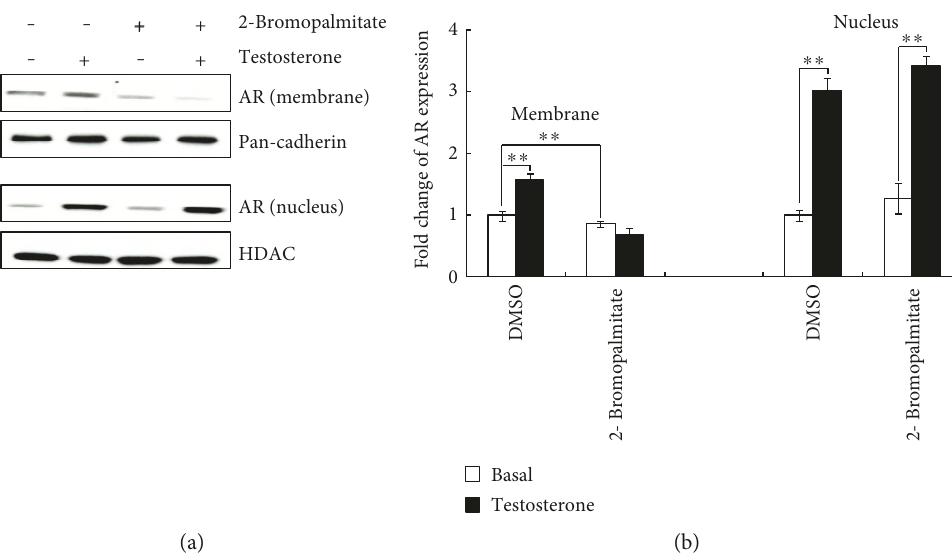
Figure 4: 2-Bromopalmitate prevented AR translocation to membrane. (a) Representative Western blot images showing AR transport in the membrane and nuclear fraction proteins from cells preincubated with vehicle (DMSO) or 2-bromopalmitate for 2 h before exposure to 10nM testosterone. (b) Pooled data from 3 individual experiments. Data are expressed as mean ± SEM, and the values are calculated from the fold change of DMSO basal. The concentration of 2-bromopalmitate used in this study is 50 μ M. ∗∗ P < 0 01